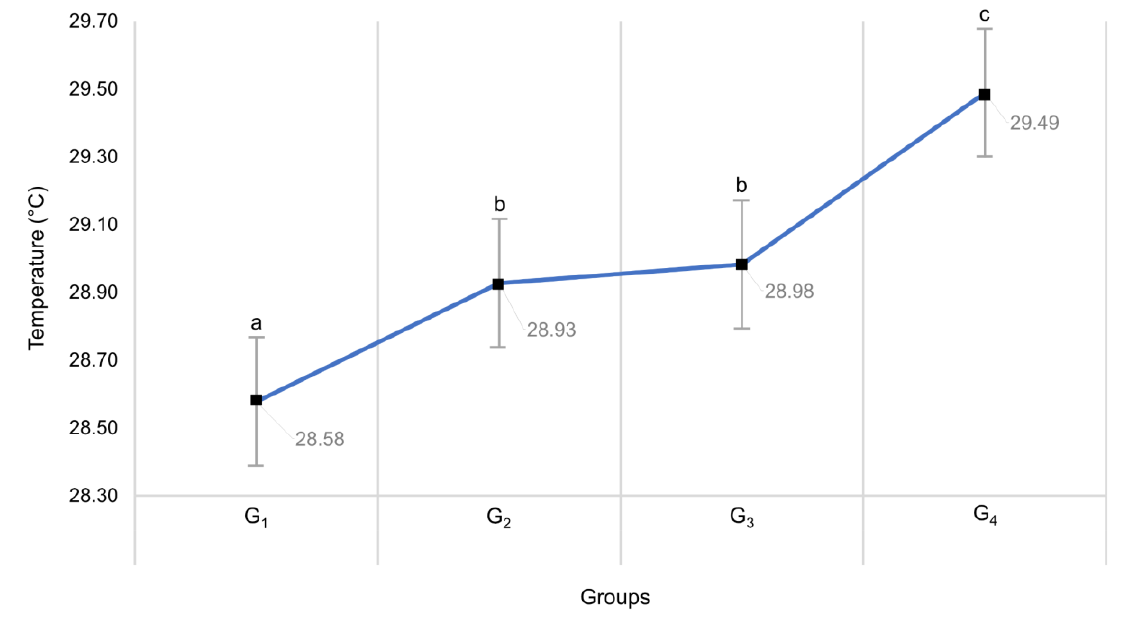
Figure 2. Mean ± standard error of the temperatures in the 4 groups of bitches. Different letters (a,b,c) indicate significant differences in temperatures between the 4 groups of bitches (G 1 , 4 – 8 Kg; G 2 , 8.1 – 16 Kg; G 3 , 16.1 – 32 Kg; G 4 , 32.1 – 39.6 Kg) and in the 7 measurement times.